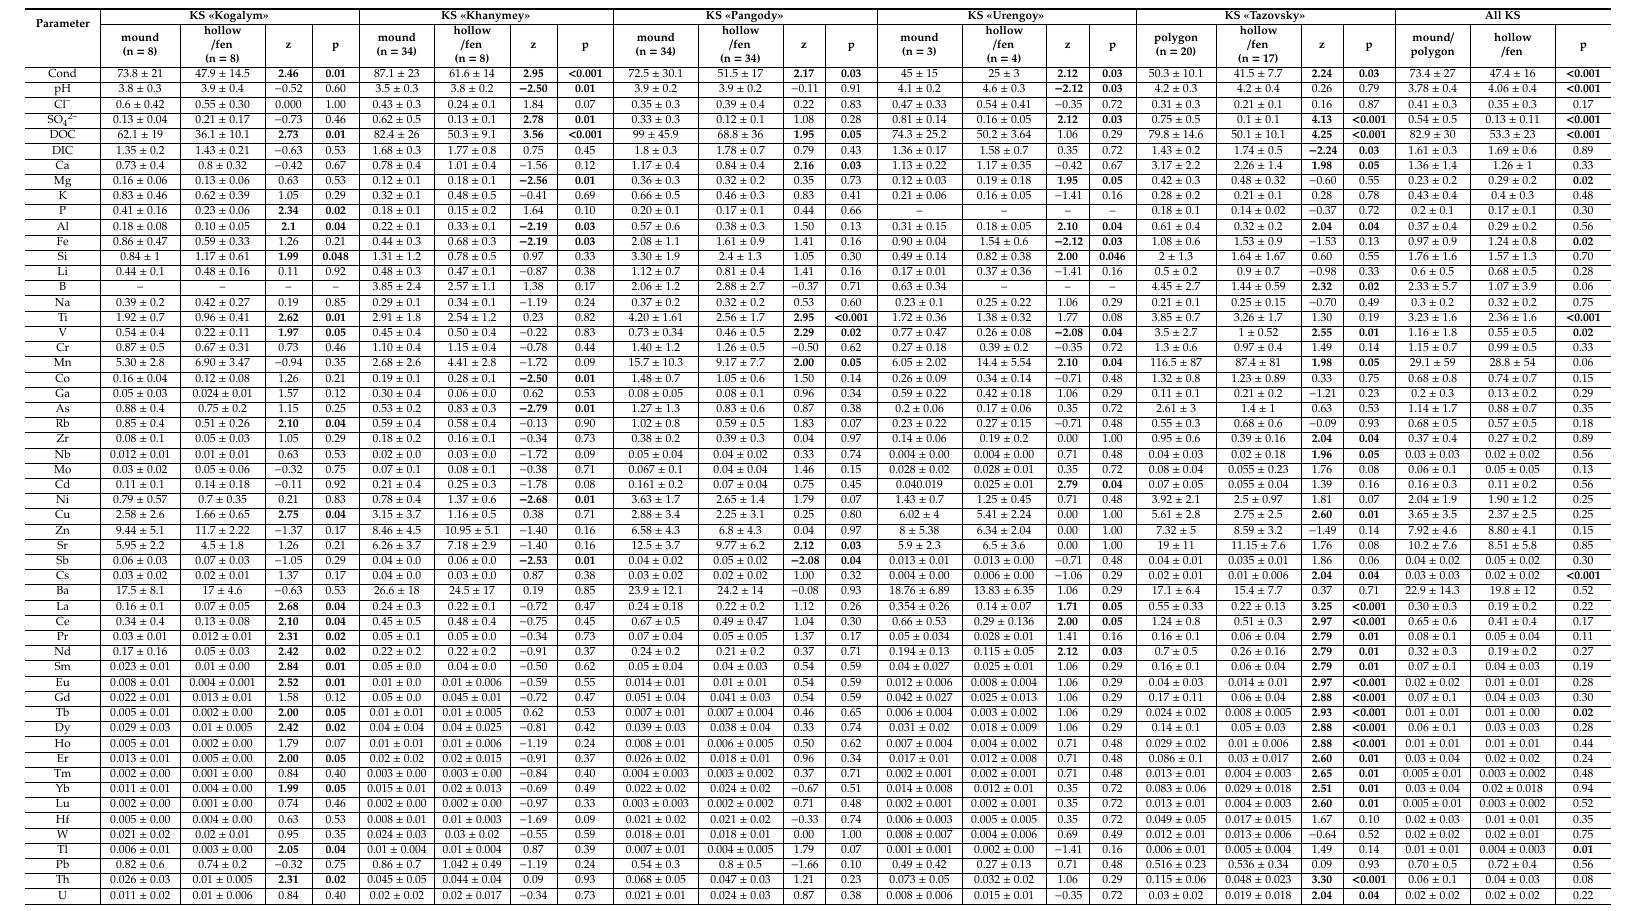
Table A1. Mean values (M ± SD) and statistical di ff erences ( p < 0.05) of DOC, major and trace elements concentration in bog waters of two microtopes. p -values are determined by Mann–Whitney U test. Parameters that di ff er reliably are highlighted in